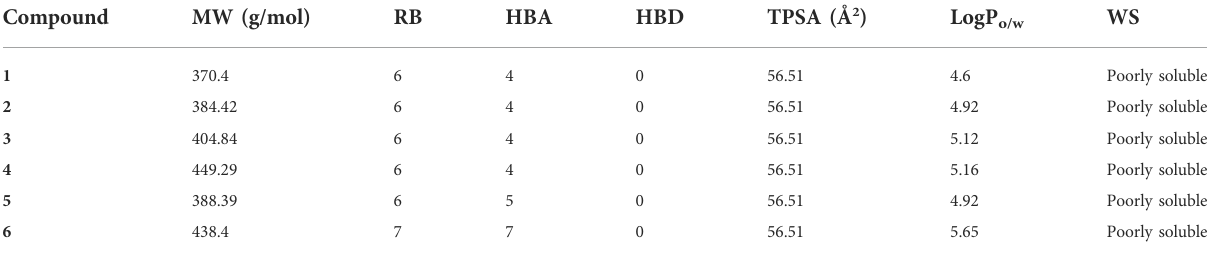
TABLE 2 The physicochemical parameters of all derivatives.